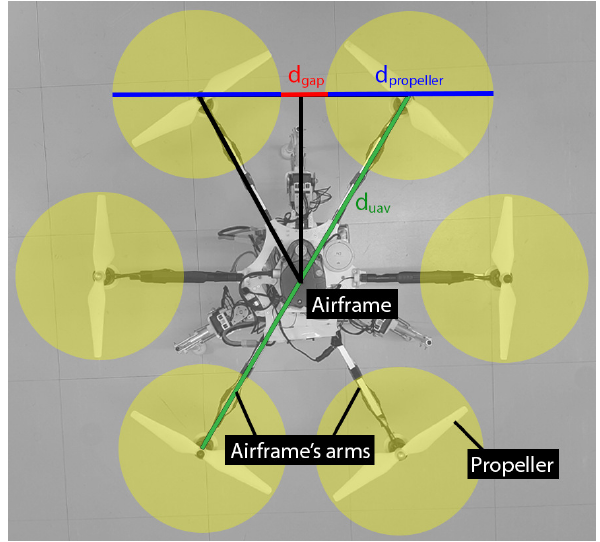
Figure 6. Relationship between airframe diameter, propeller length and distance between the propellers to pass the manipulators